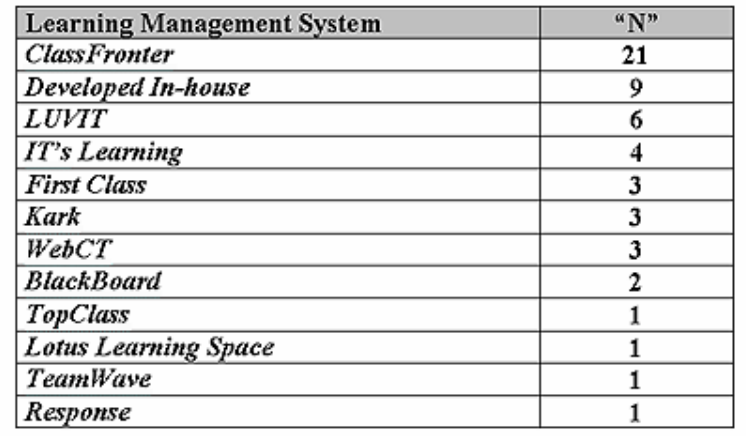
Table 3. Number of Learning Management Systems used in 54 Norwegian institutions of higher education (Source: Runnestø and Ristesund,